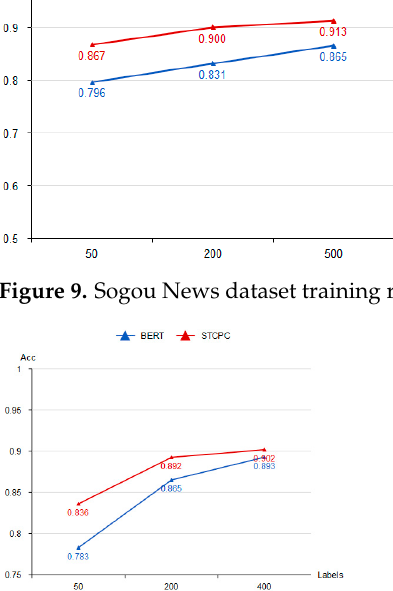
Figure 10. Yahoo Answers dataset training results.